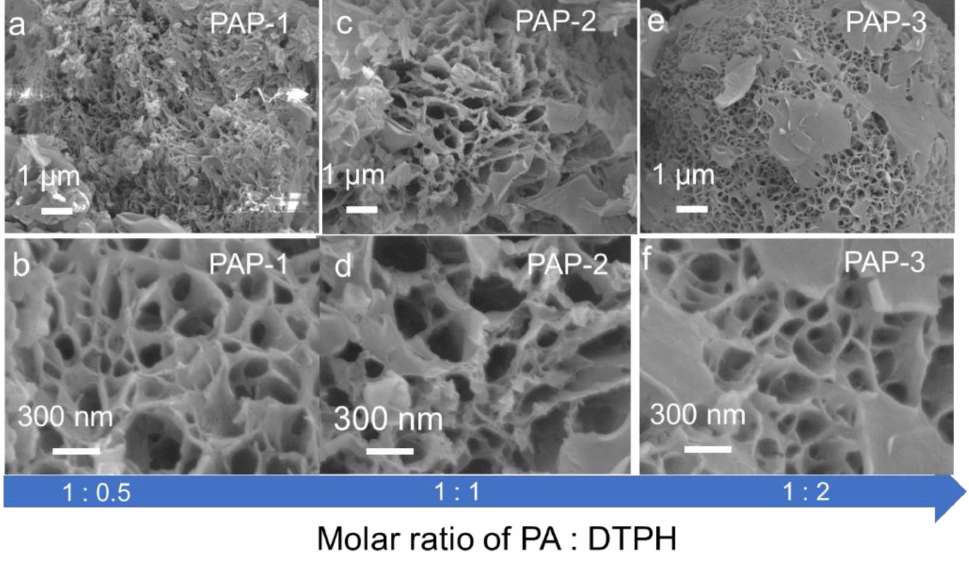
Figure 3. SEM images of ( a , b ) PAP-1, ( c , d ) PAP-2, and ( e , f ) PAP-3. Similarly, the self-assembly of DTPH and 4,4 (cid:48) -biphenyldicarboxaldehyde